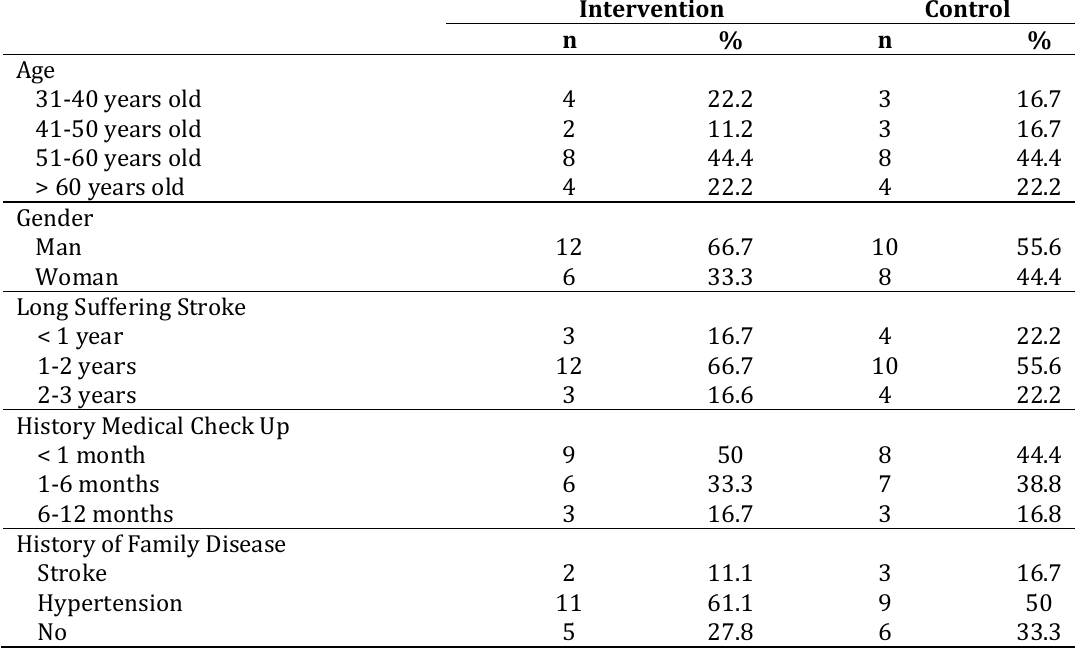
Frequency Distribution of Sociodemographic Indicator (n=36)